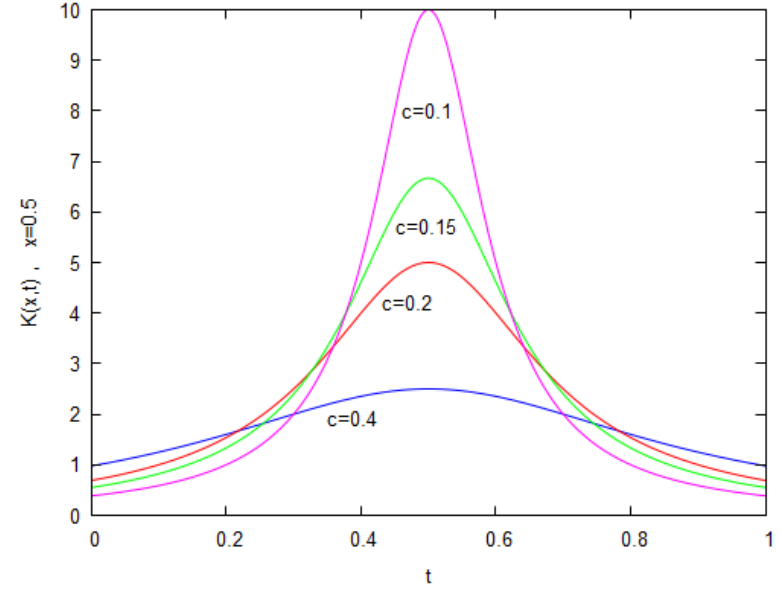
Figure 2. Function K ( x , t ) in (51), x =